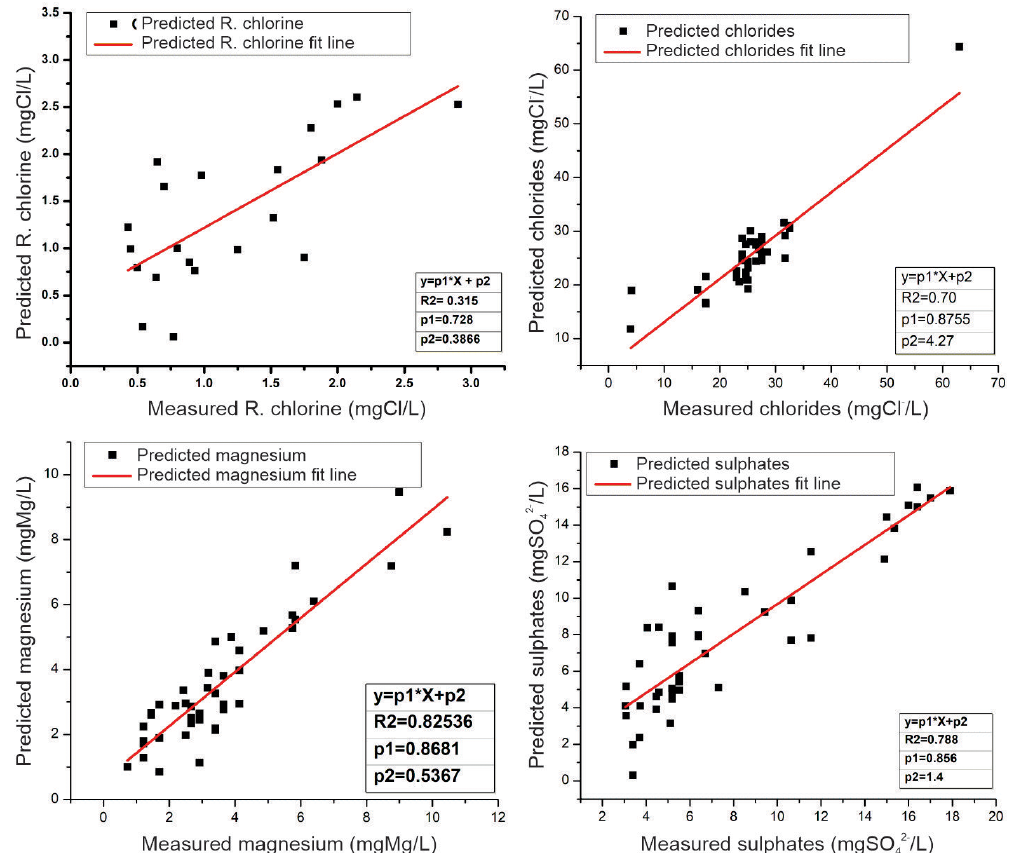
Figure 7. Regression models of physicochemical parameters (residual chlorine, chlorides, magnesium, and sulfates) generated by smart electronic tongue and traditional methods of chemical